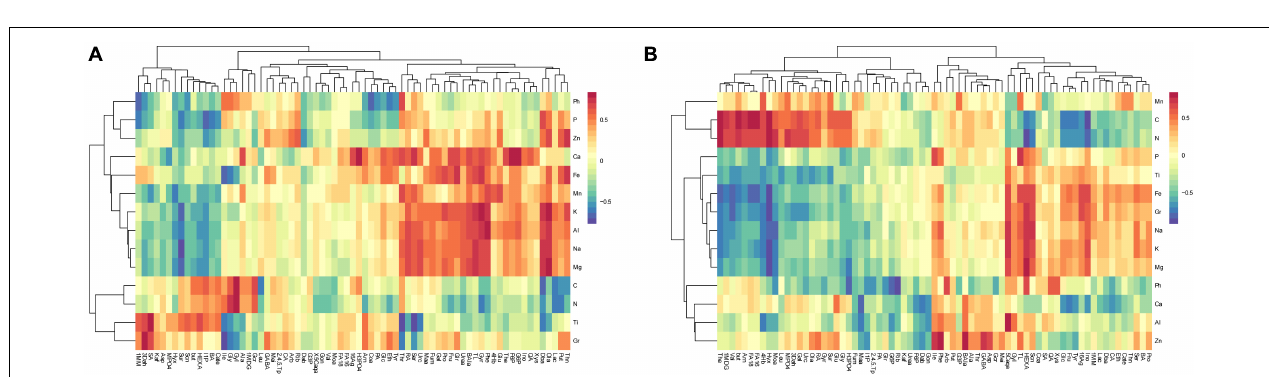
FIGURE 5 | Metabolic pathways in needles of A. faxoniana at 3,500, 3,000, and 2,600 m caused by warming. Values were used for intensities of the detected metabolites. H1, the altitude of 3,500 m; H2, the altitude of 3,000 m; H3, the altitude of 2,600 m. PEP, phosphoenolpyruvic acid; 3-PGA, 3-phosphoglyceric acid.